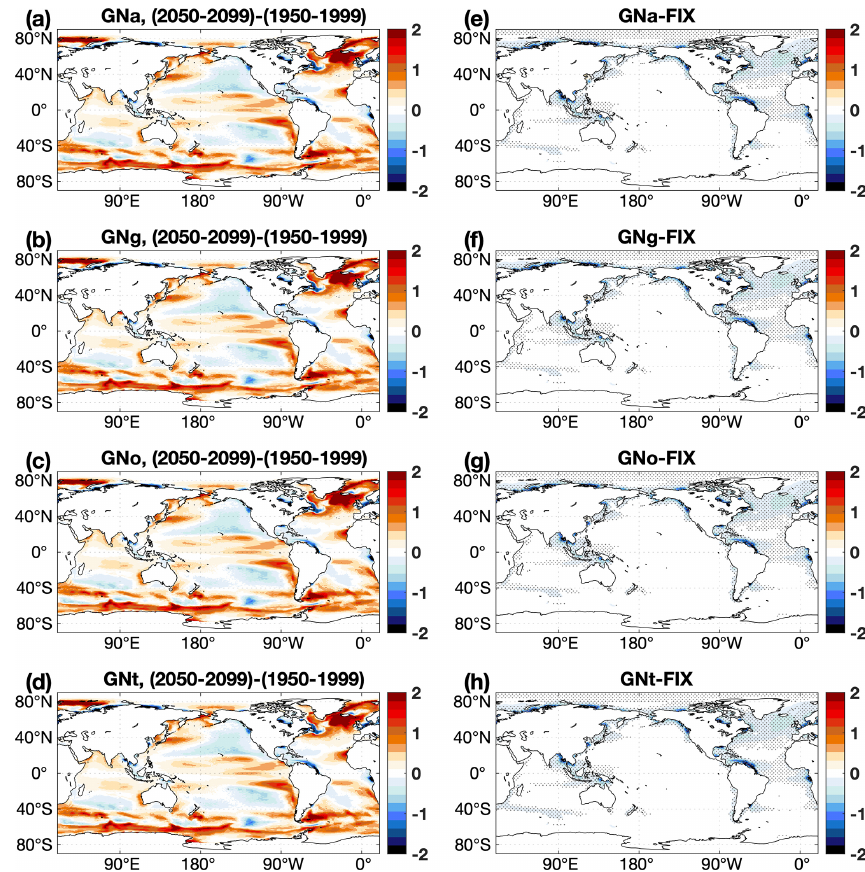
Figure 10. (a–d) Projected changes in annual mean air–sea CO 2 fluxes (molCm − 2 yr − 1 ) in four GNS experiments between the 2050–2099 and the 1950–1999 periods. (e–h) The difference in projected changes in annual mean air–sea CO 2 fluxes (molCm − 2 yr − 1 ) between each GNS experiment and FIX. In panels (e–h) , only significant differences are plotted, and dots denote areas where the signal is larger than the standard deviation of the absolute field (see details in Appendix